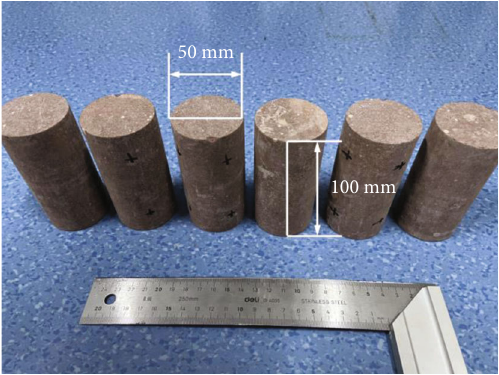
Figure 2: The prepared red sandstone